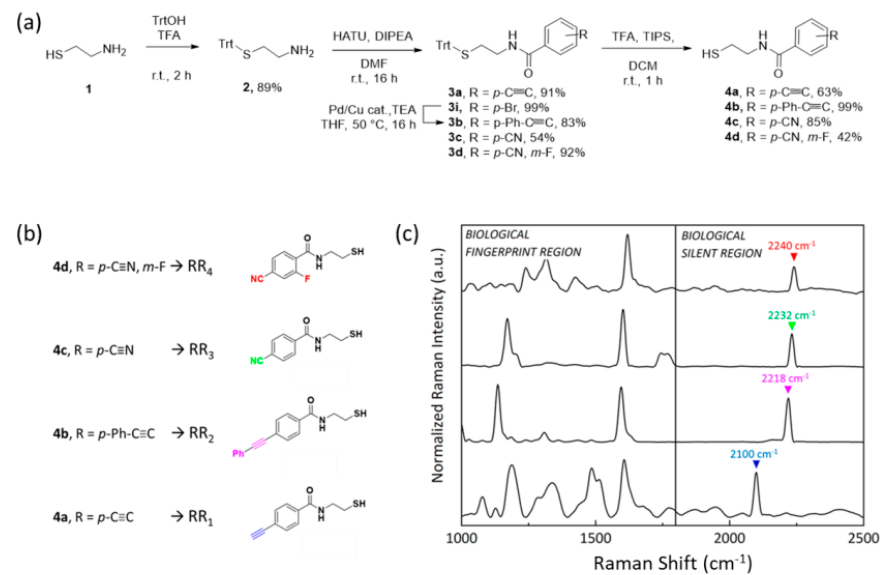
Figure 2. ( a ) General strategy implemented to synthesize bioorthogonal Raman reporters 4a – d from cysteamine 1. ( b ) Chemical structure of the four compounds 4a – d and ( c ) normalized Raman spectra of the 4a – d powder.